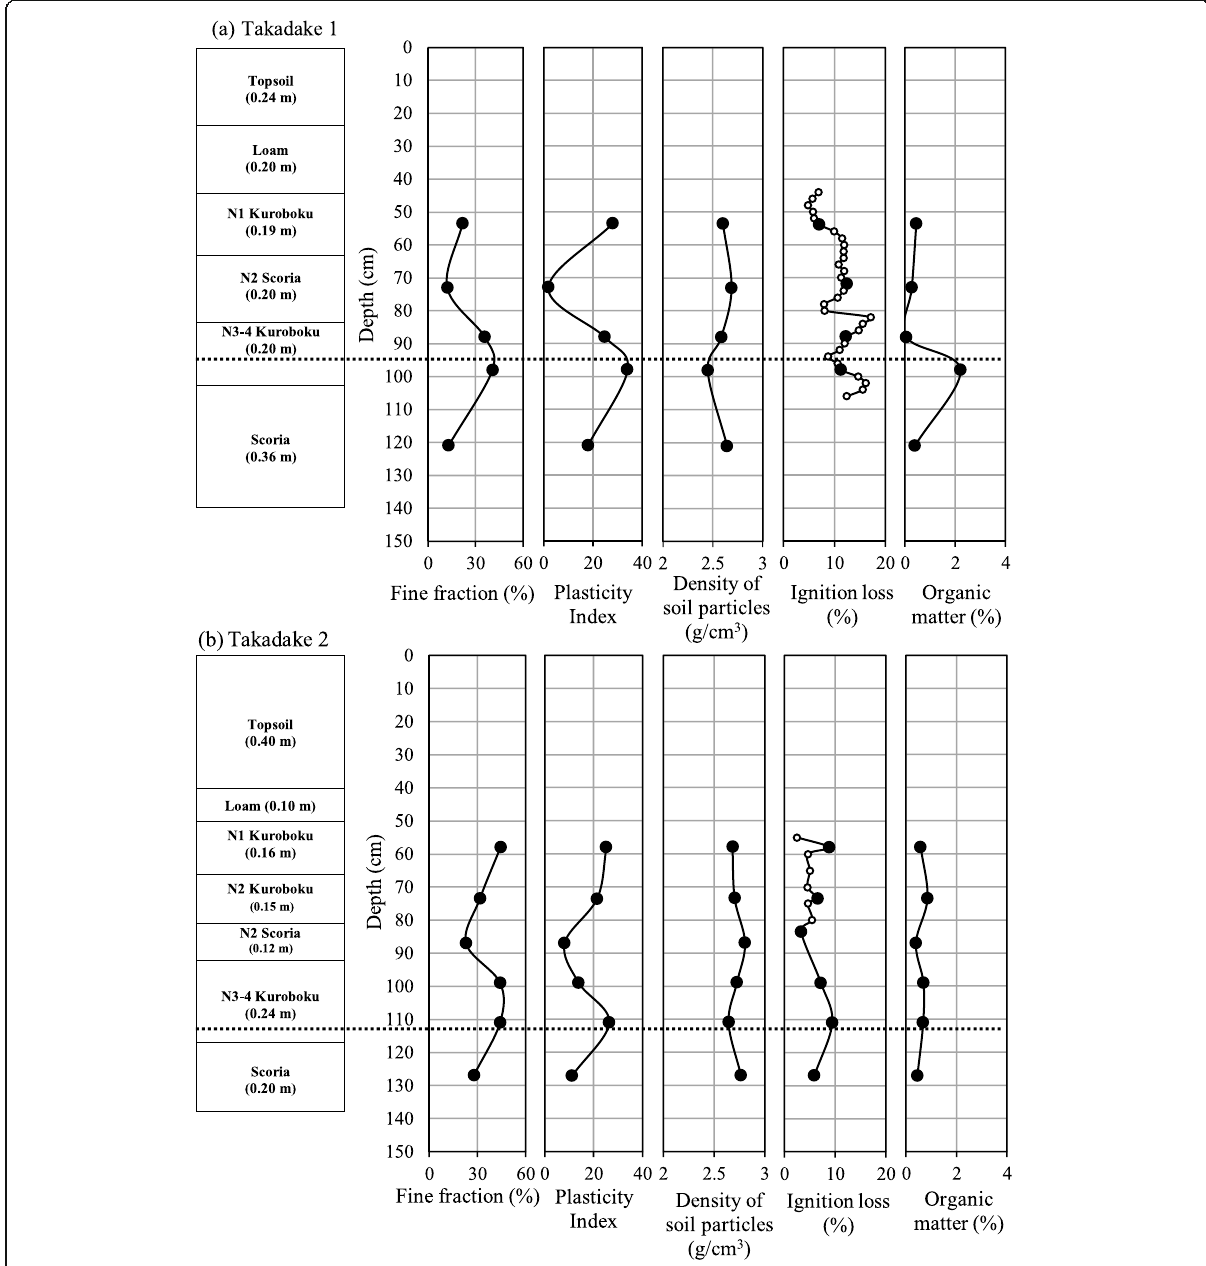
Fig. 5 Physical properties of soil and sliding layer; dotted lines indicated location of sliding layer by field